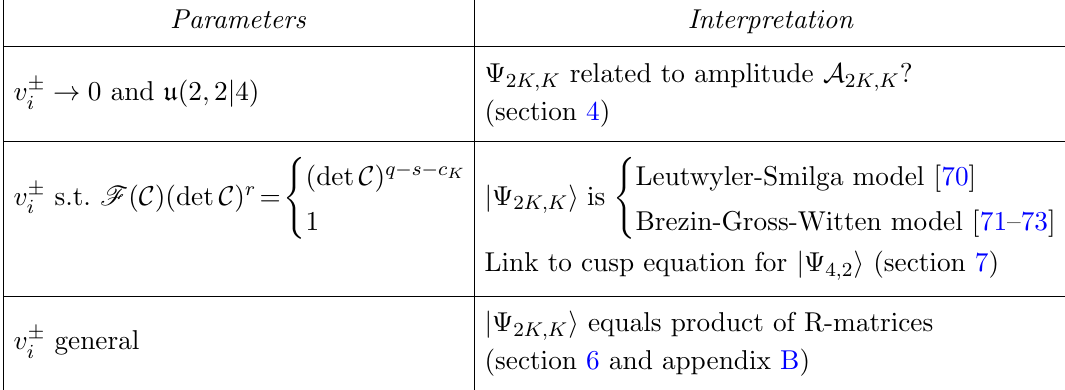
Table 1 . Interpretations of the unitary Gra(cid:25)mannian integrals (3.5) and (5.7) for di(cid:11)erent defor- mation parameters v (cid:6) in the integrand F ( C i